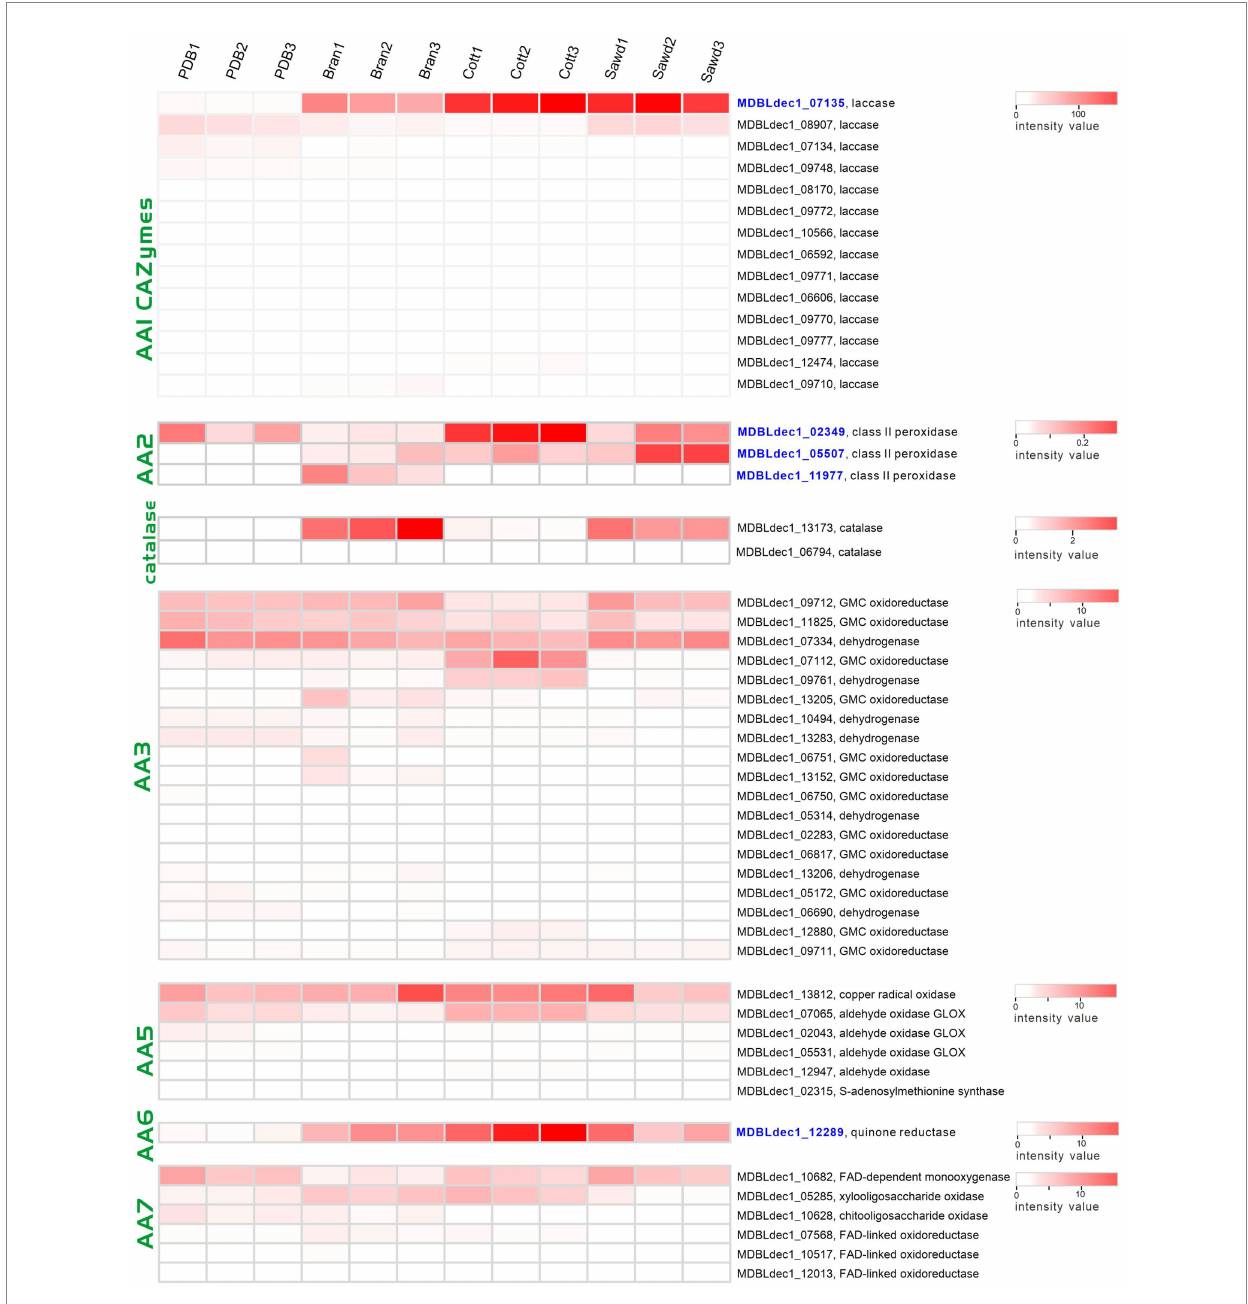
FIGURE 7 Heatmap of the lignin modification enzymes (LMEs) identified in four groups. The color represents the value of the normalized abundance of each